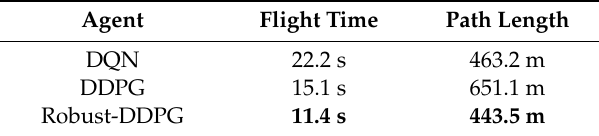
Table 2. The exploiting e ff